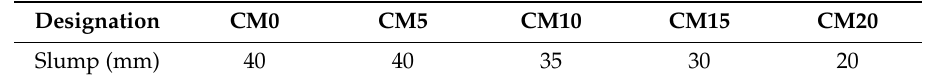
Table 3. Concrete slump test